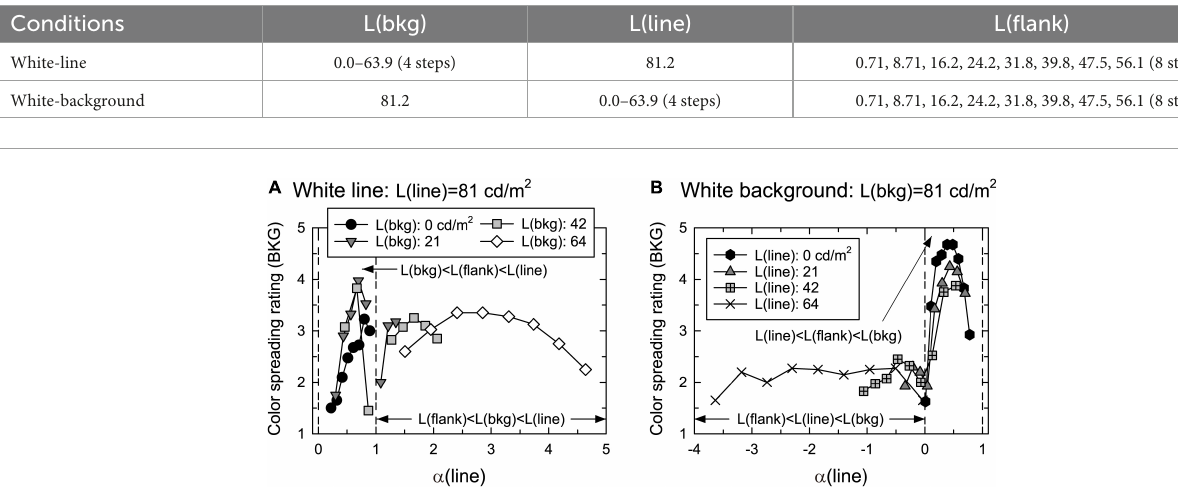
TABLE 2 Luminance conditions in Experiment 2.